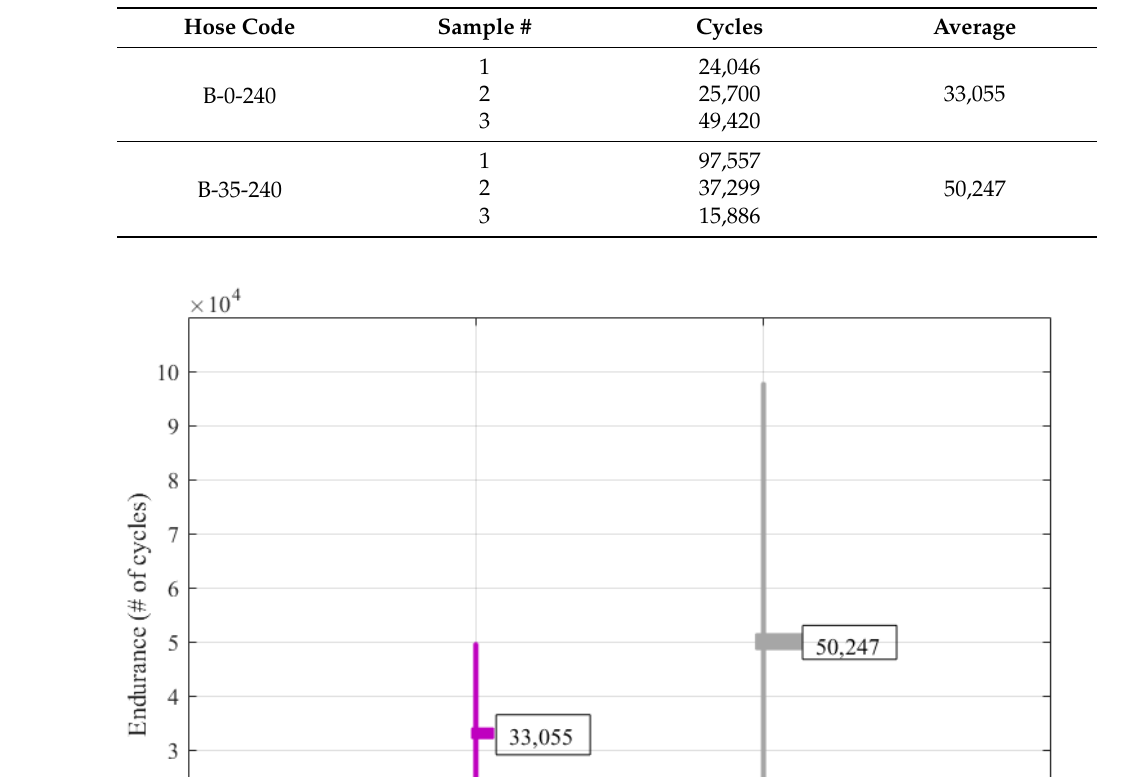
Table 6. Average of the number of cycles each hose in sample set 2 performed until failure.